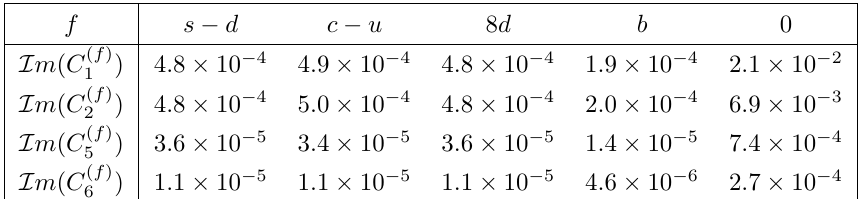
Table 2 . Upper bounds on CP violating (cid:1) c = 1 operators from j (cid:15) 0 =(cid:15) j , at the hadronic charm scale (cid:22) (cid:25) 2 GeV.